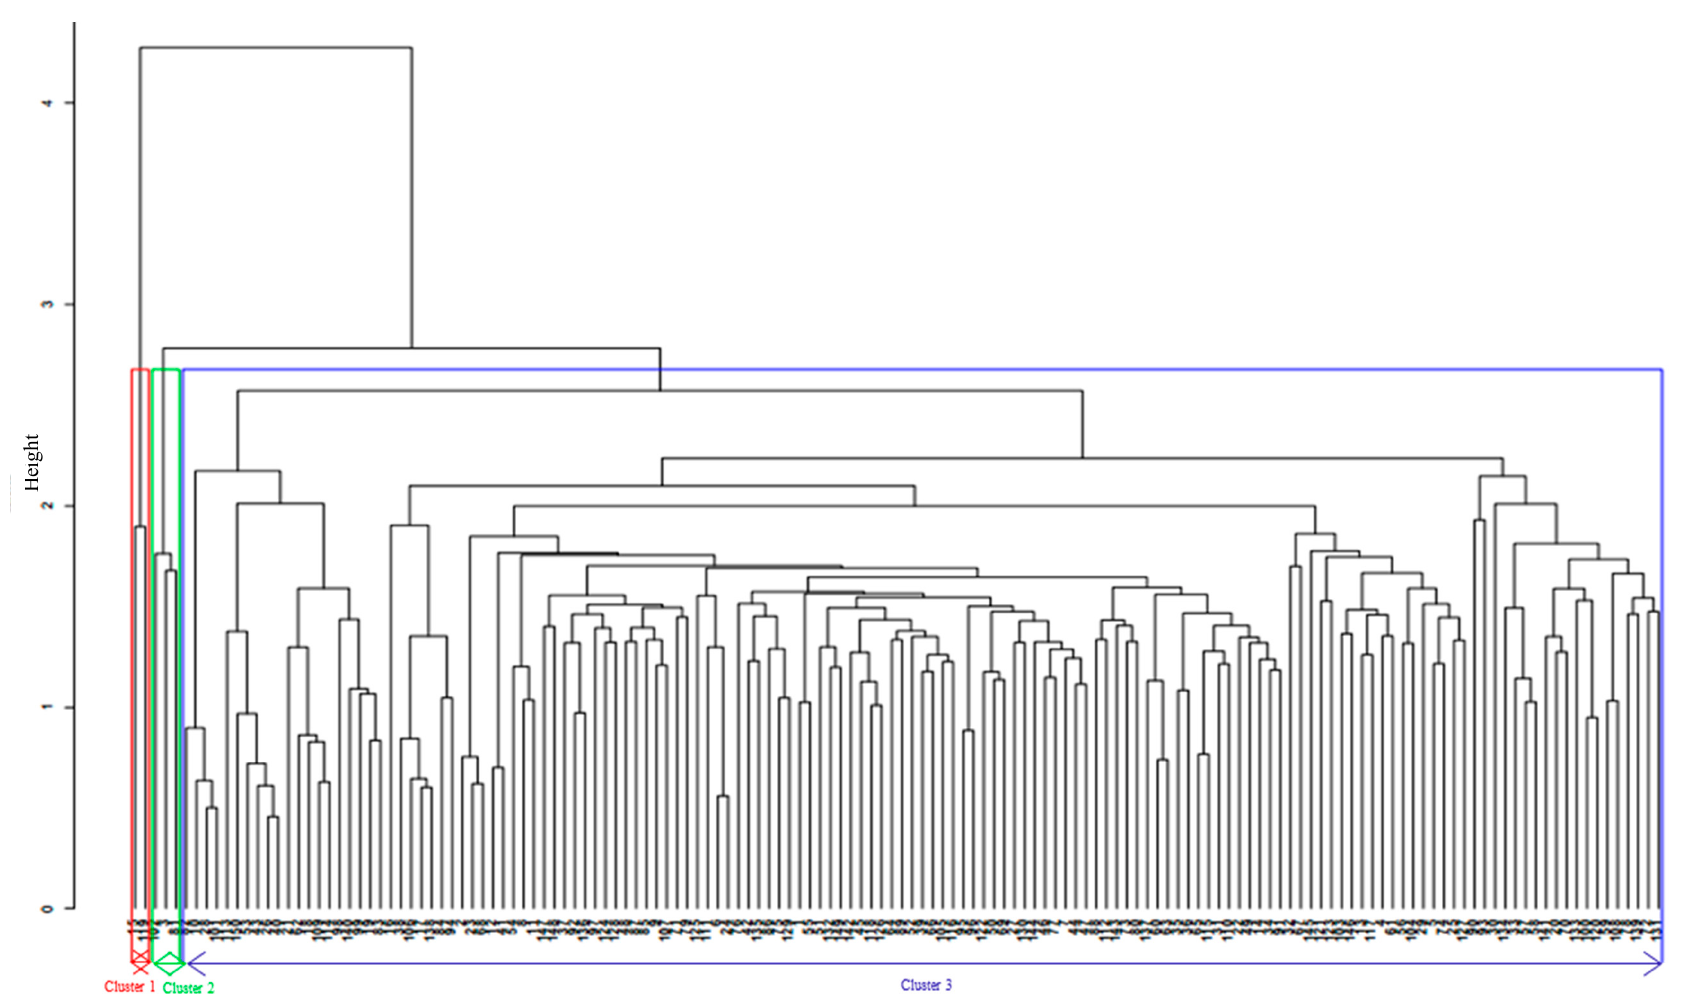
Figure 6. Hierarchical cluster analysis based on combined agronomic and molecular data using ward.D2 method.